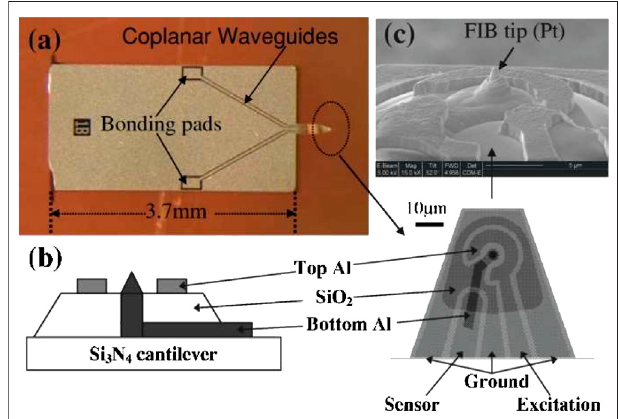
FIGURE 2 | The schematic construction of MIM. (A) Microfabricated microwave probe with two aluminum electrodes and the ground plane patterned on the Si nitride cantilever. (B) Schematic drawing of the layer structure near the probe end. (C) SEM image near the probe end [27]. Reproduced with permission from Rev. Sci. Instrum. 78, 6 (2007). Copyright 2007 American Institute of Physics.